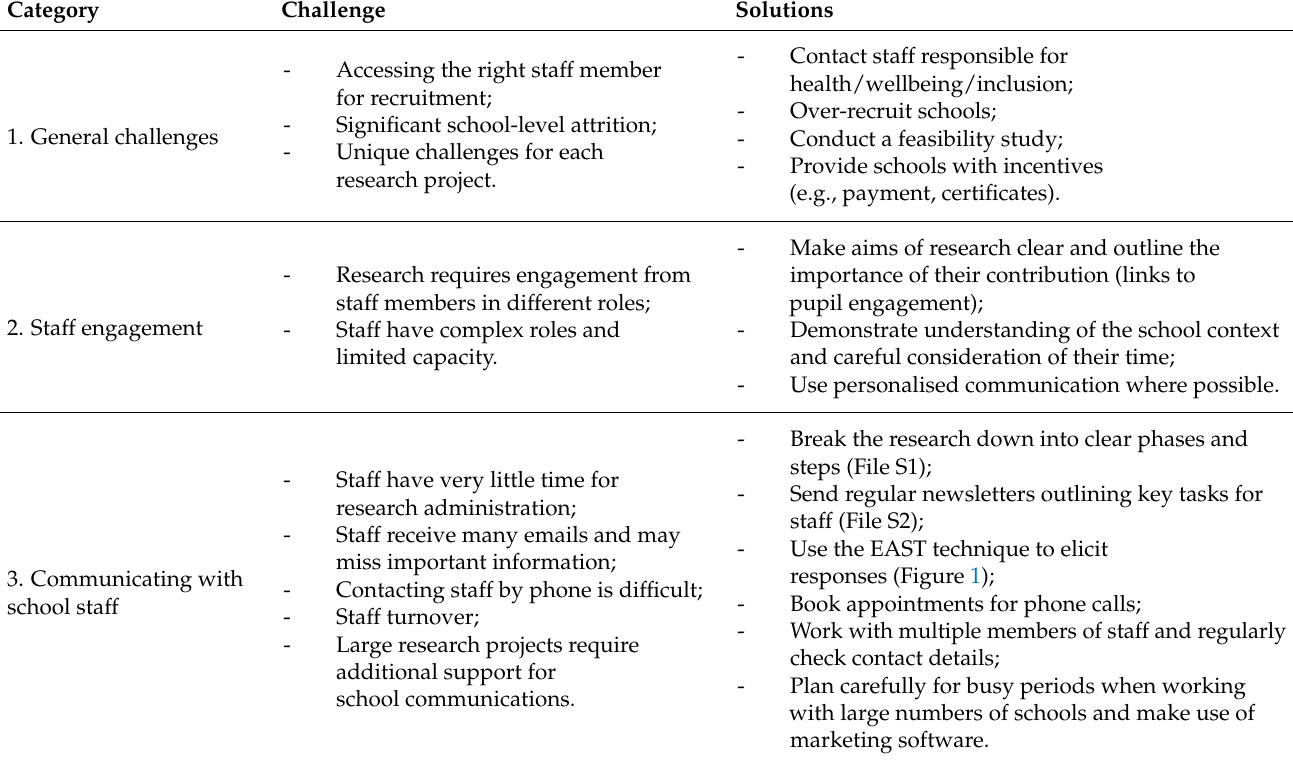
Table 1. Key challenges and solutions in the Education for Wellbeing